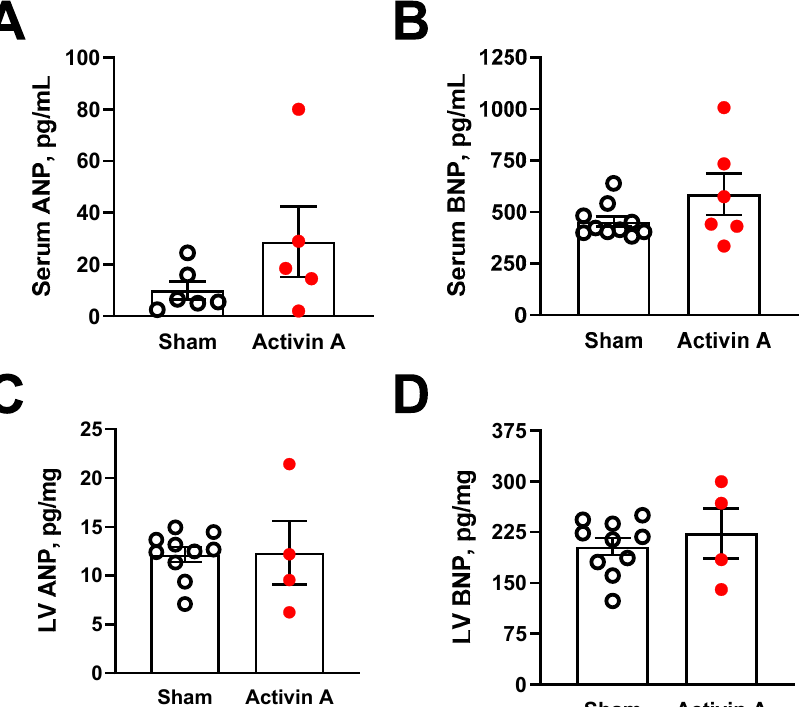
Figure 6. Circulating markers of cardiac injury. Serum ( A , B ) and left ventricular (LV; ( C , D )); concen- tration of atrial natriuretic peptide (ANP) and brain natriuretic peptide (BNP) on gestational day 19 in sham (open black circles) and activin A-infused (6 µg/day; solid red circles) pregnant rats. Data are mean ± SEM.